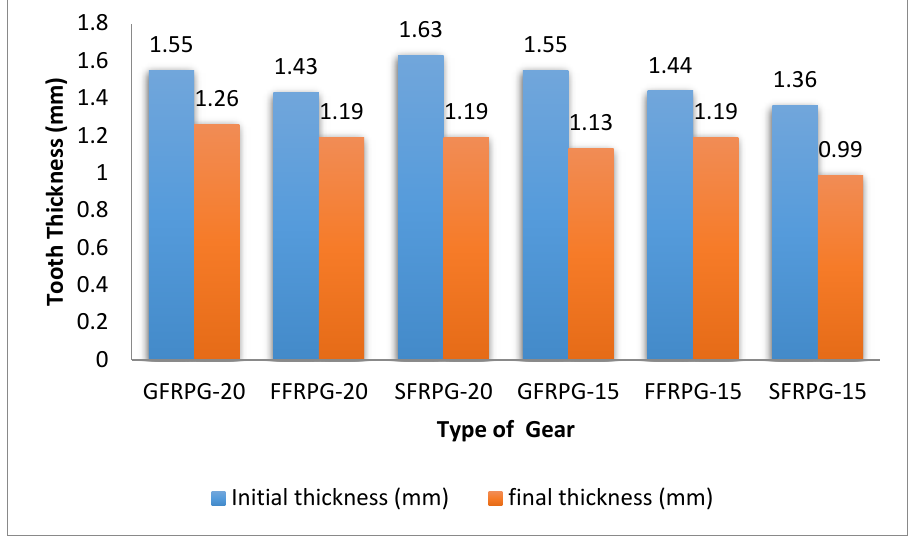
Figure 5. Comparision ofinitial and final thickness for all the gears.